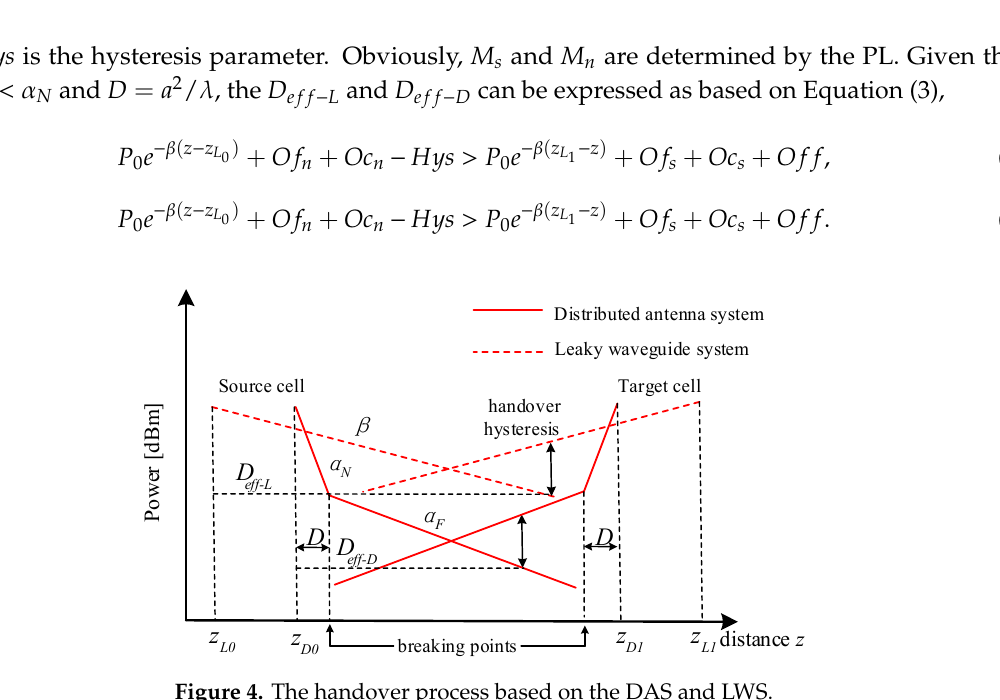
Figure 4. The handover process based on the DAS and LWS.